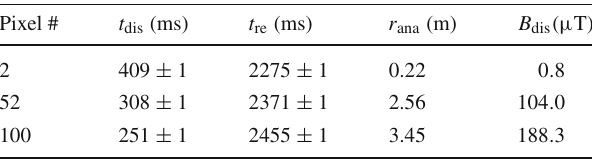
Table 3 Timing of the magnetic pulse with a pulse length of 2 s for the three investigated detector pixels. The table lists the the beam dis- /reappearance times t dis , t re during a pulse cycle and the corresponding fieldlineradiusintheanalyzingplane r was estimated from Eq.